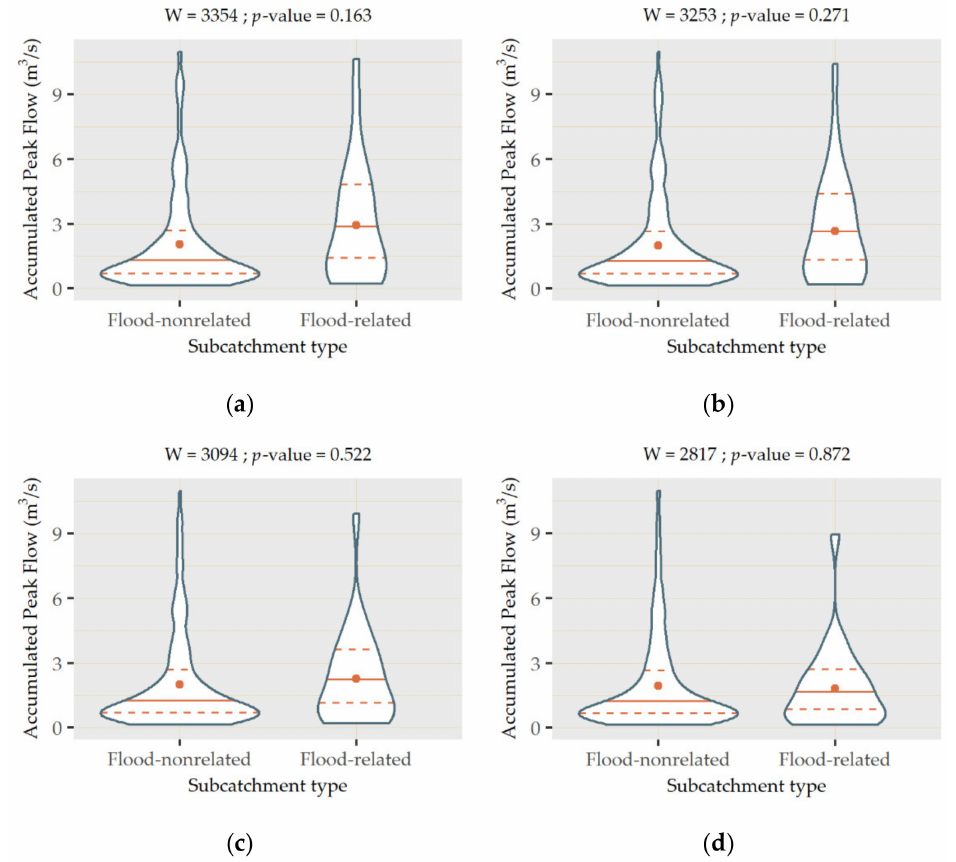
Figure 9. Violin plots of the values of accumulated peak flow in flood-related and flood-nonrelated subcatchments when substituting different proportions of built-up land cover classes with permeable pavements and green infrastructure: ( a ) 10% replacement, ( b ) 25% replacement, ( c ) 50% replacement, and ( d ) 100%